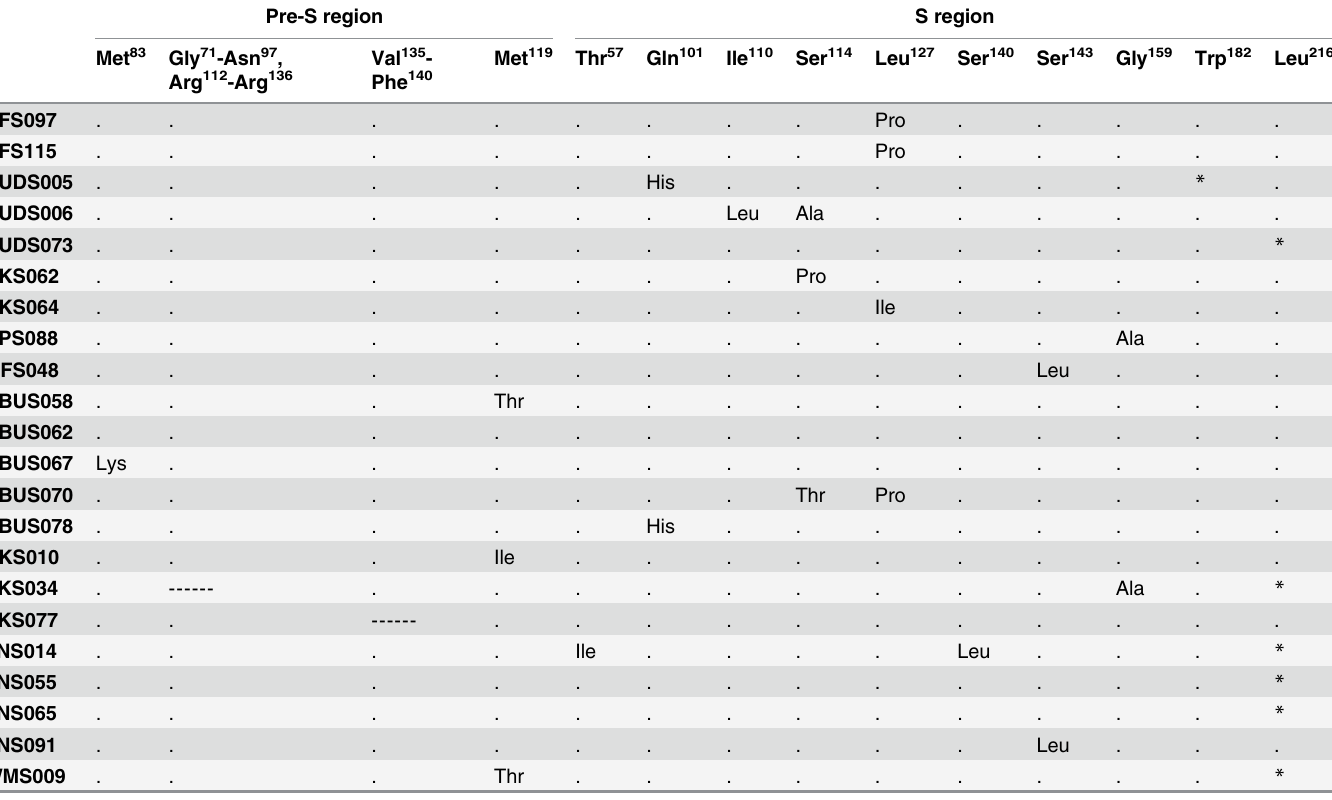
Table 2. Comparison of deduced amino acids of sequences obtained in this study and HBV/E